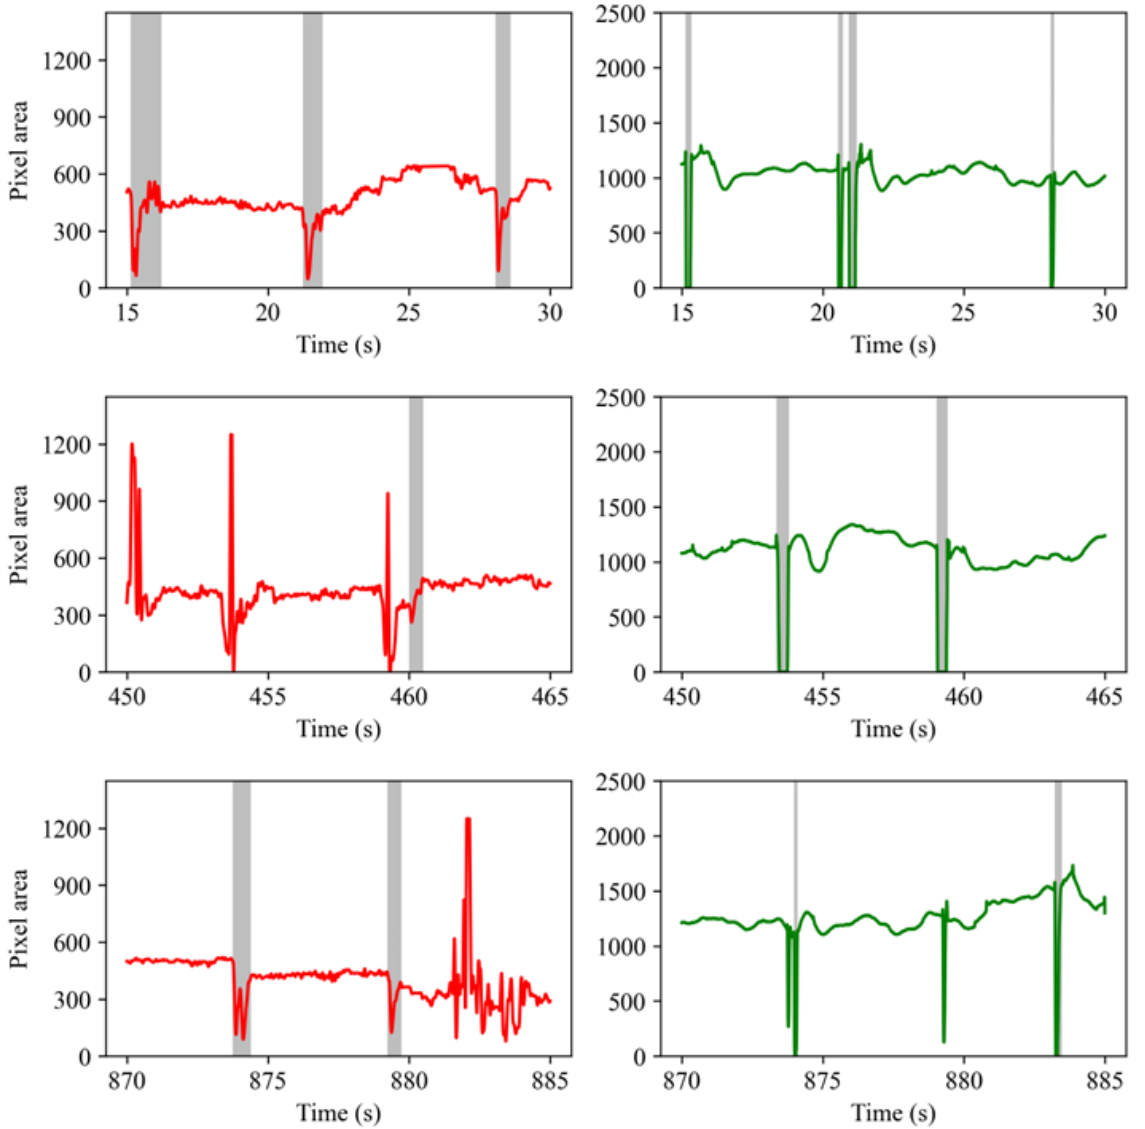
Figure 9. The eye blinks detected from the glass ( left panel ) and EyeLink ( right panel ) data recorded from Subject #3. Red lines represent the eye area data from our glasses; Green lines represent the pupil area data from the EyeLink eye ‐ tracker. The detected blinks are marked with gray strips.